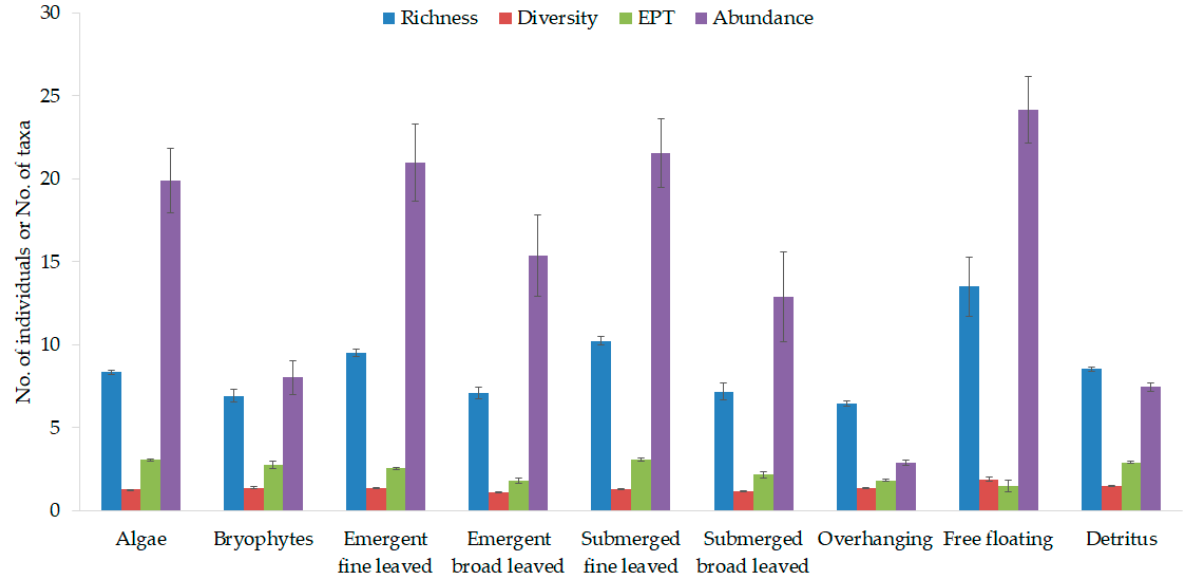
Figure 5. Average (±standard error) taxonomic richness (No. of taxa), Shannon’s diversity, Ephemeroptera–Plecoptera–Trichoptera richness (No. of EPT taxa), and total abundance (No. of individuals/10) of benthic macroinvertebrates of each vegetation type.